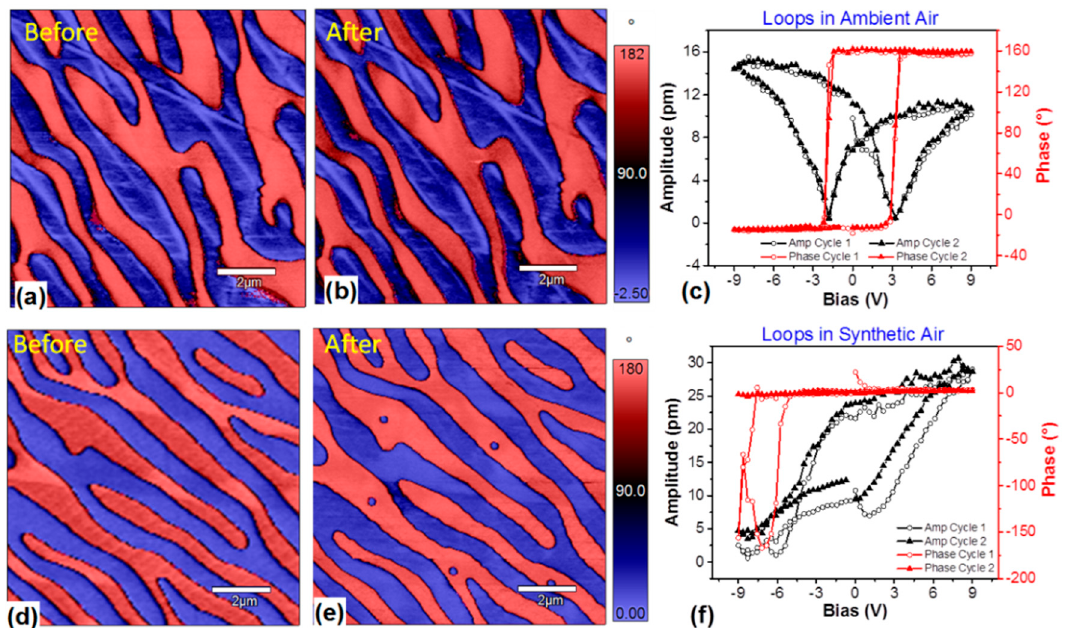
Figure 4. ( a , d ) PFM phase images of PZN − 9%PT before PFS in the ambient air and the synthetic air, respectively; ( b , e ) PFM phase images after PFS in the ambient air and the synthetic air, respectively; and ( c , f ) hysteresis loops in the ambient air and the synthetic air, respectively.